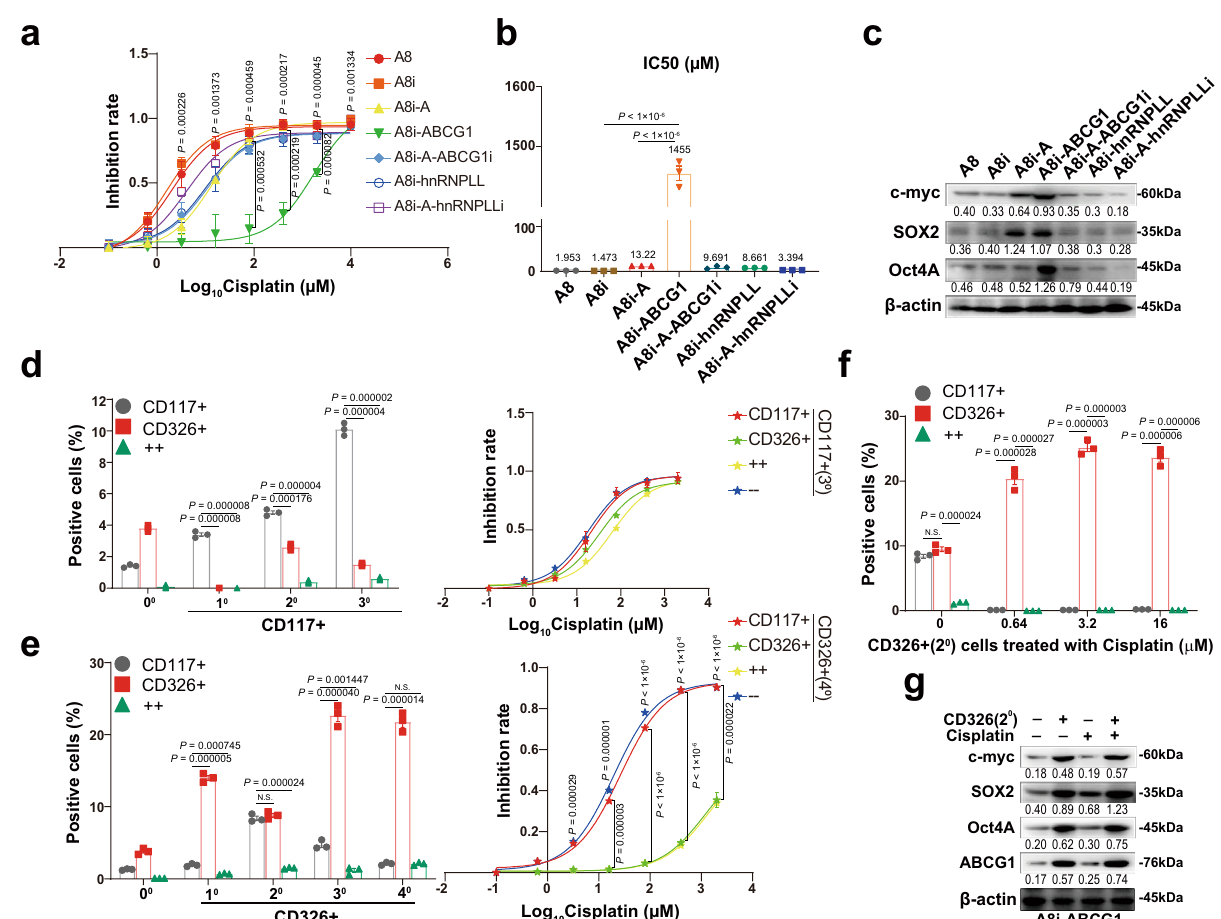
Fig. 7 ABCG1 confers cancer cell stemness and cisplatin resistance through upregulation of CD326. Inhibition rates of various cell lines treated with cisplatin in terms of silencing or overexpression of ECM1, ABCG1, and hnRNPLL ( a , data are presented as mean ± SD, n = 3 biologically independent repeats, two-tailed t -test was calculated between A8i-ABCG1 and A8i <upper> or A8i-A <lower>) and IC50 values ( b , data are presented as mean ± SD, n = 3 biologically independent repeats, two-tailed t -test) of cisplatin in these cells as detected by CCK-8 assay. c Expression of stem cell transcription factors detected by WB analysis in ECM1-, ABCG1-, and hnRNPLL-silenced or -overexpressing cells. d Numbers of CD117 + and CD326 + cells (left panel, data are presented as ± SD, n = 3 biologically independent repeats, two-tailed t -test) and cisplatin inhibition rates (right panel, data are presented as ± SD, n = 3 biologically independent repeats) after three selection-and-culture cycles from CD117 + cells. e Numbers of CD117 + and CD326 + cells (left panel, data are presented as mean ± SD, n = 3 biologically independent repeats, two-tailed t -test) and cisplatin inhibition rates (right panel, data are presented as mean ± SD, n = 3 biologically independent repeats, two-tailed t -test was calculated between CD117 + and CD326 + <upper> or CD117 + /CD326 + and CD117 − /CD326 − ) after four selection-and-culture cycles from CD326 + cells. f A low concentration of cisplatin enriches CD326 + cells to increase cancer cell stemness. Data are presented as mean ± SD, n = 3 biologically independent repeats, two-tailed t -test. g Cisplatin treatment upregulates the expression of stem cell transcription factors in CD326 +